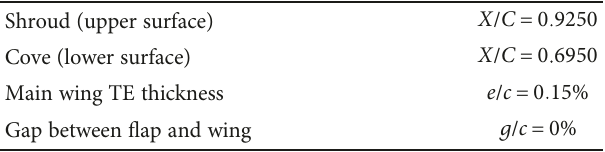
Table 4: Geometrical constraints used for fl ap